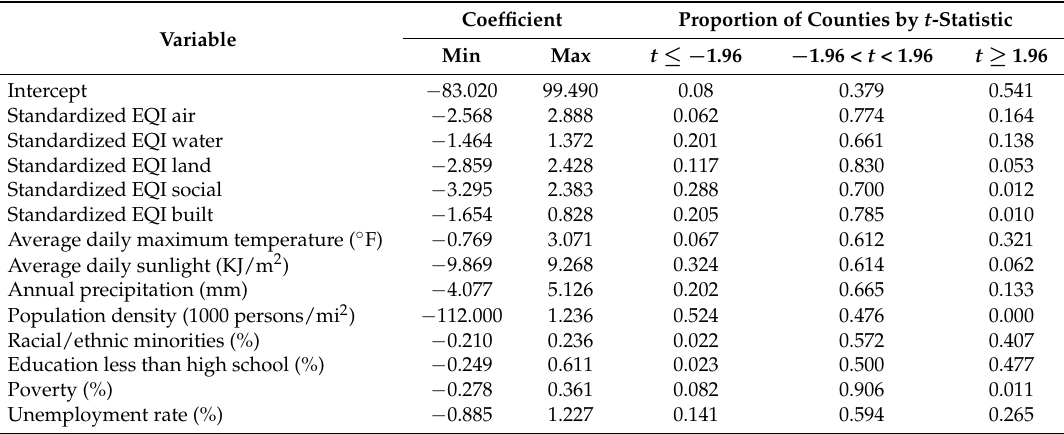
Table 5. Estimated effect of overall environmental quality index (EQI) on county-level prevalence of physical inactivity using geographically weighted regression (GWR).